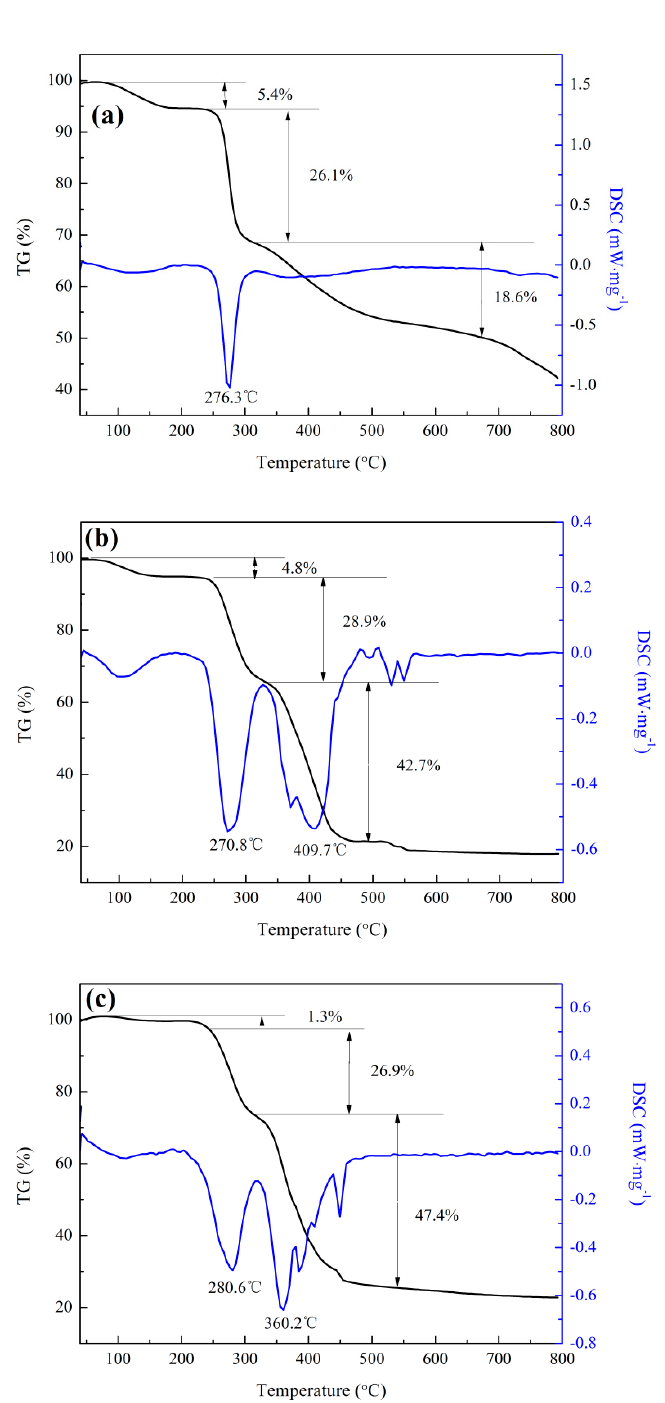
Figure 5. Thermal gravimetric curves of ( a ) CMCS, ( b ) P(AM-DMC), and ( c ) CCPAD.